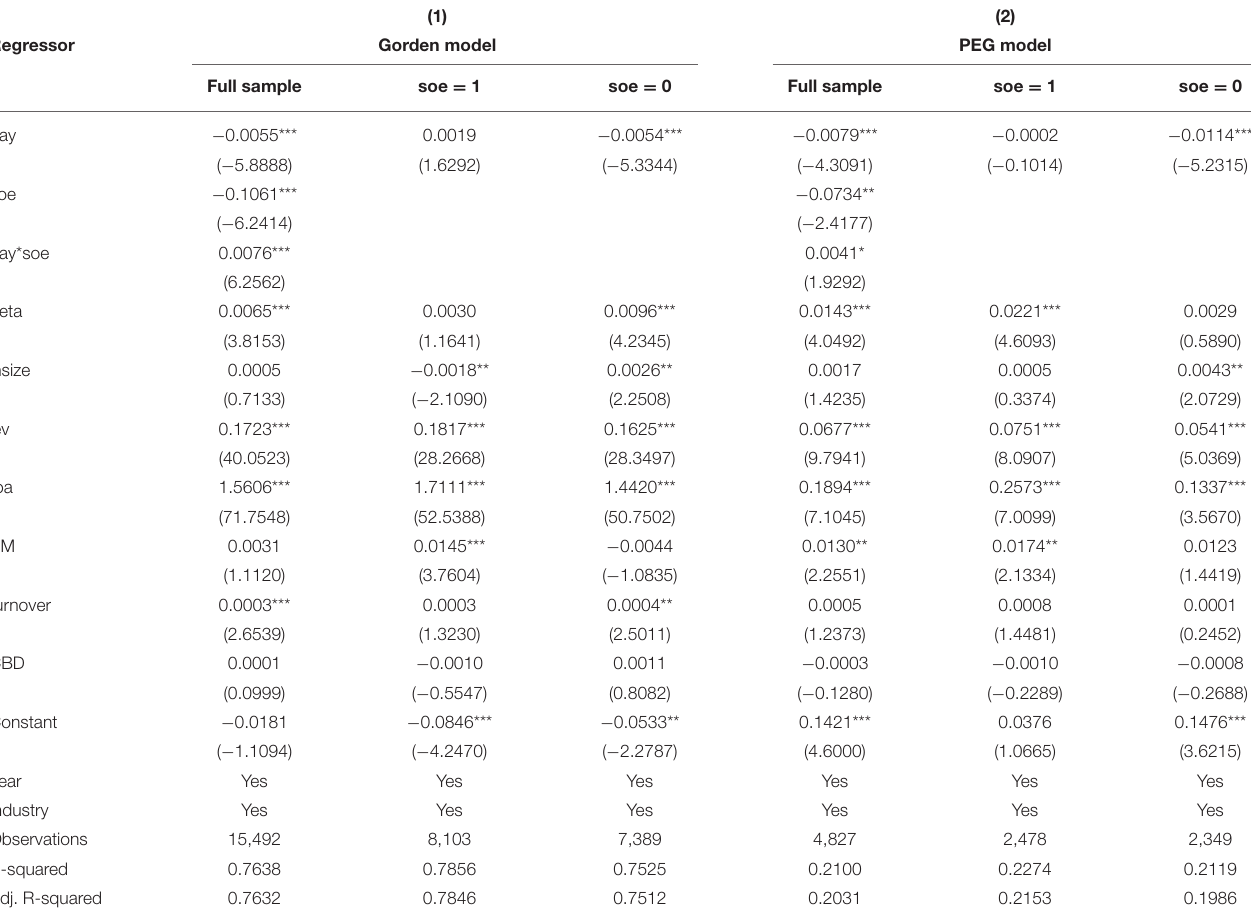
TABLE 6 | The moderating effect of property